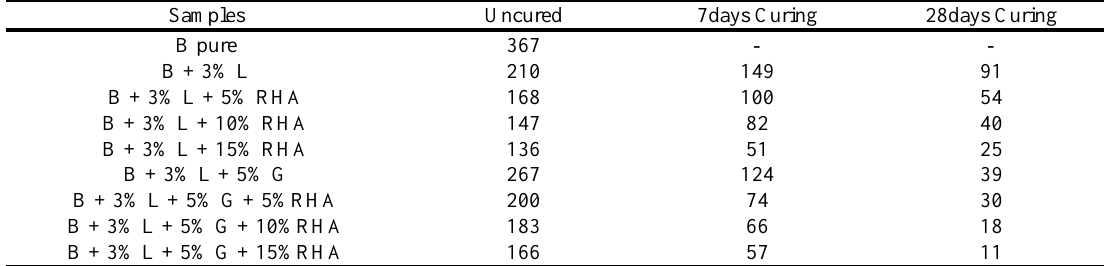
Figure 5. Effect of curing time on swelling pressure of soil stabilized with 3% of lime and 15% of RHA Table 5 summary of final swelling pressures measured (in